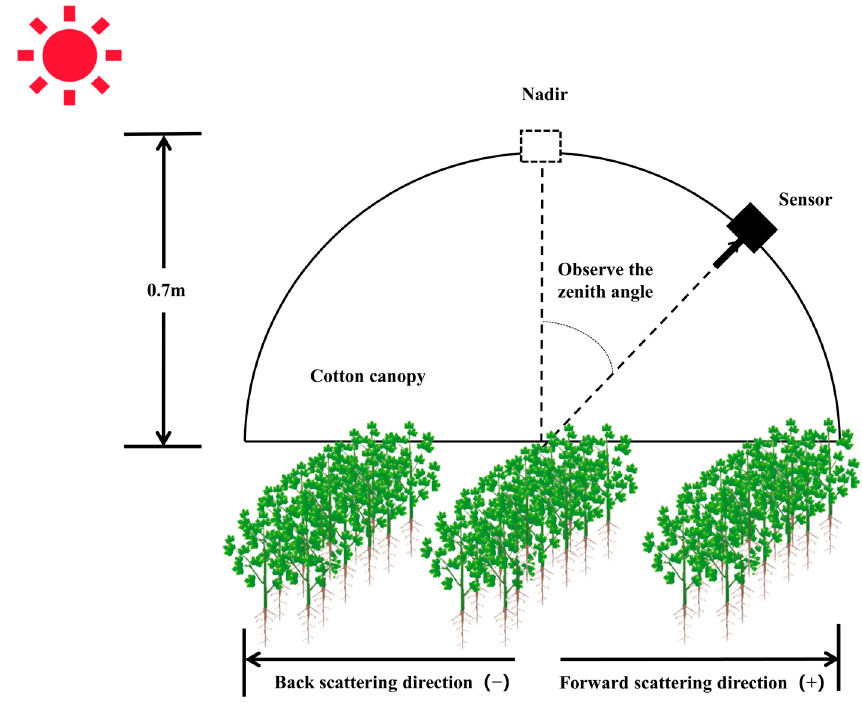
Figure 2. Schematic diagram of measurement method.